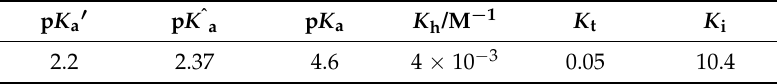
Table 4. Equilibrium constants of the compound 4 (cid:48) ,7-dihydroxy-3-methoxyflavylium. p K a